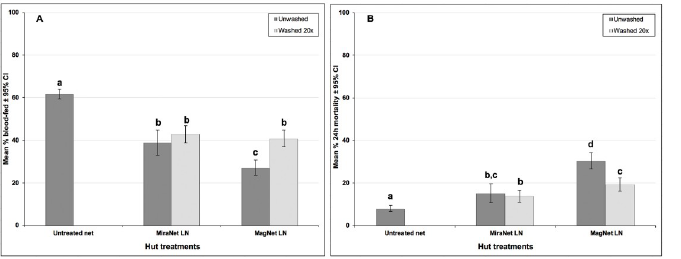
Fig 1. Experimental hut trial against wild free-flying pyrethroid resistant An . gambiae s.l. M’be´ with MiraNet and MagNet LNs. (A) Percentage blood-feeding, (B) Percentage mortality. Bars bearing the same letter label are not significantly different at the 5% level (p < 0.05, GLMMs). Error bars represent 95% CIs.